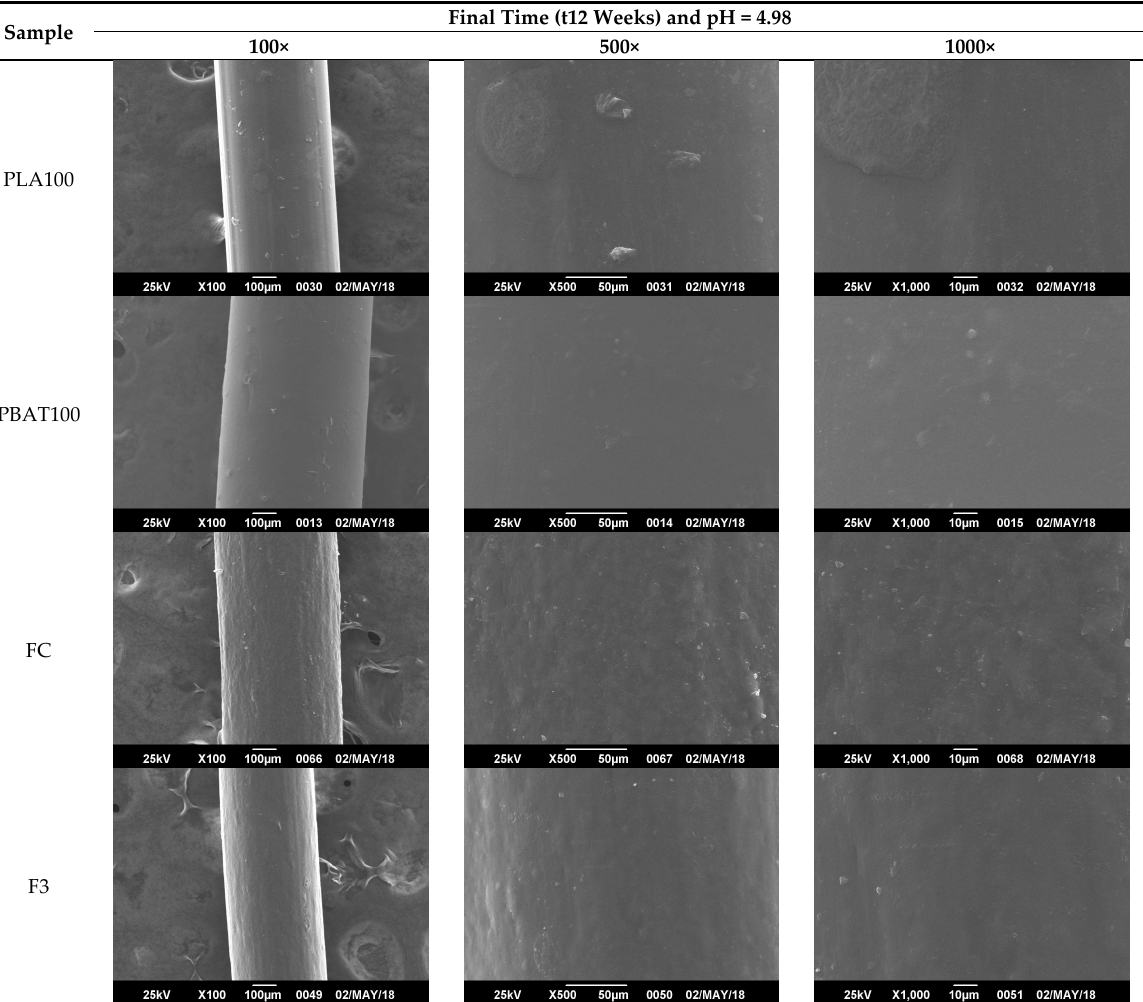
Figure 12. SEM micrographs of fibers’ surface morphology degraded for 12 weeks at pH = 4.98 and T = 25 °C.